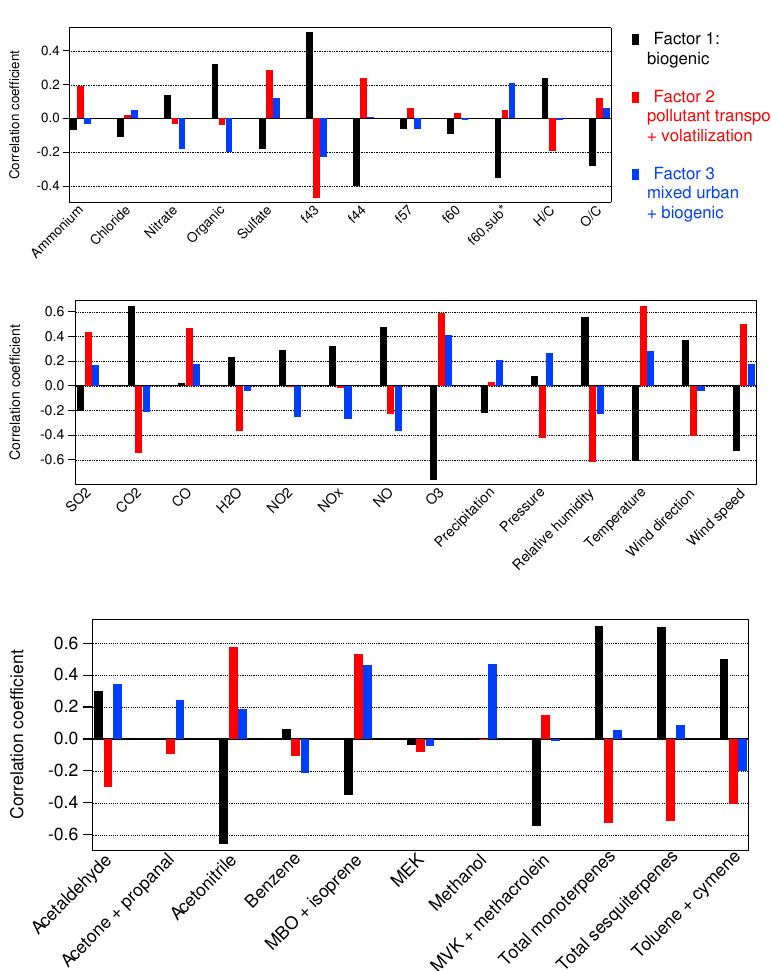
Figure 9. Correlation coefficients ( r ) of PMF factors with (a) aerosol species measured by the standalone AMS, (b) trace gas measurements and meteorological parameters, and (c) volatile organic compounds measured by PTR-TOF-MS. Correlation coefficients of PMF factors with TAG compounds are shown in Table S4. f 60 , sub refers to the fraction of m/z 60 after subtraction of background SOA (0.3% of AMS organic